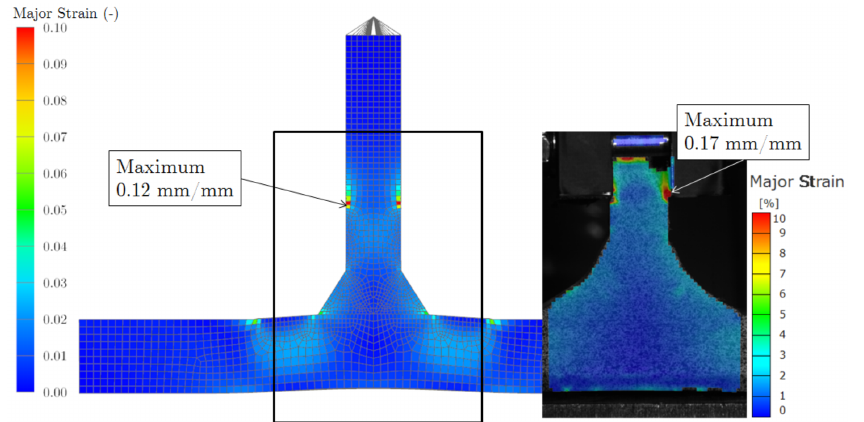
Figure 8. Local validation of the subcomponent reference model FE Analysis at an actuator displacement of 2 mm.